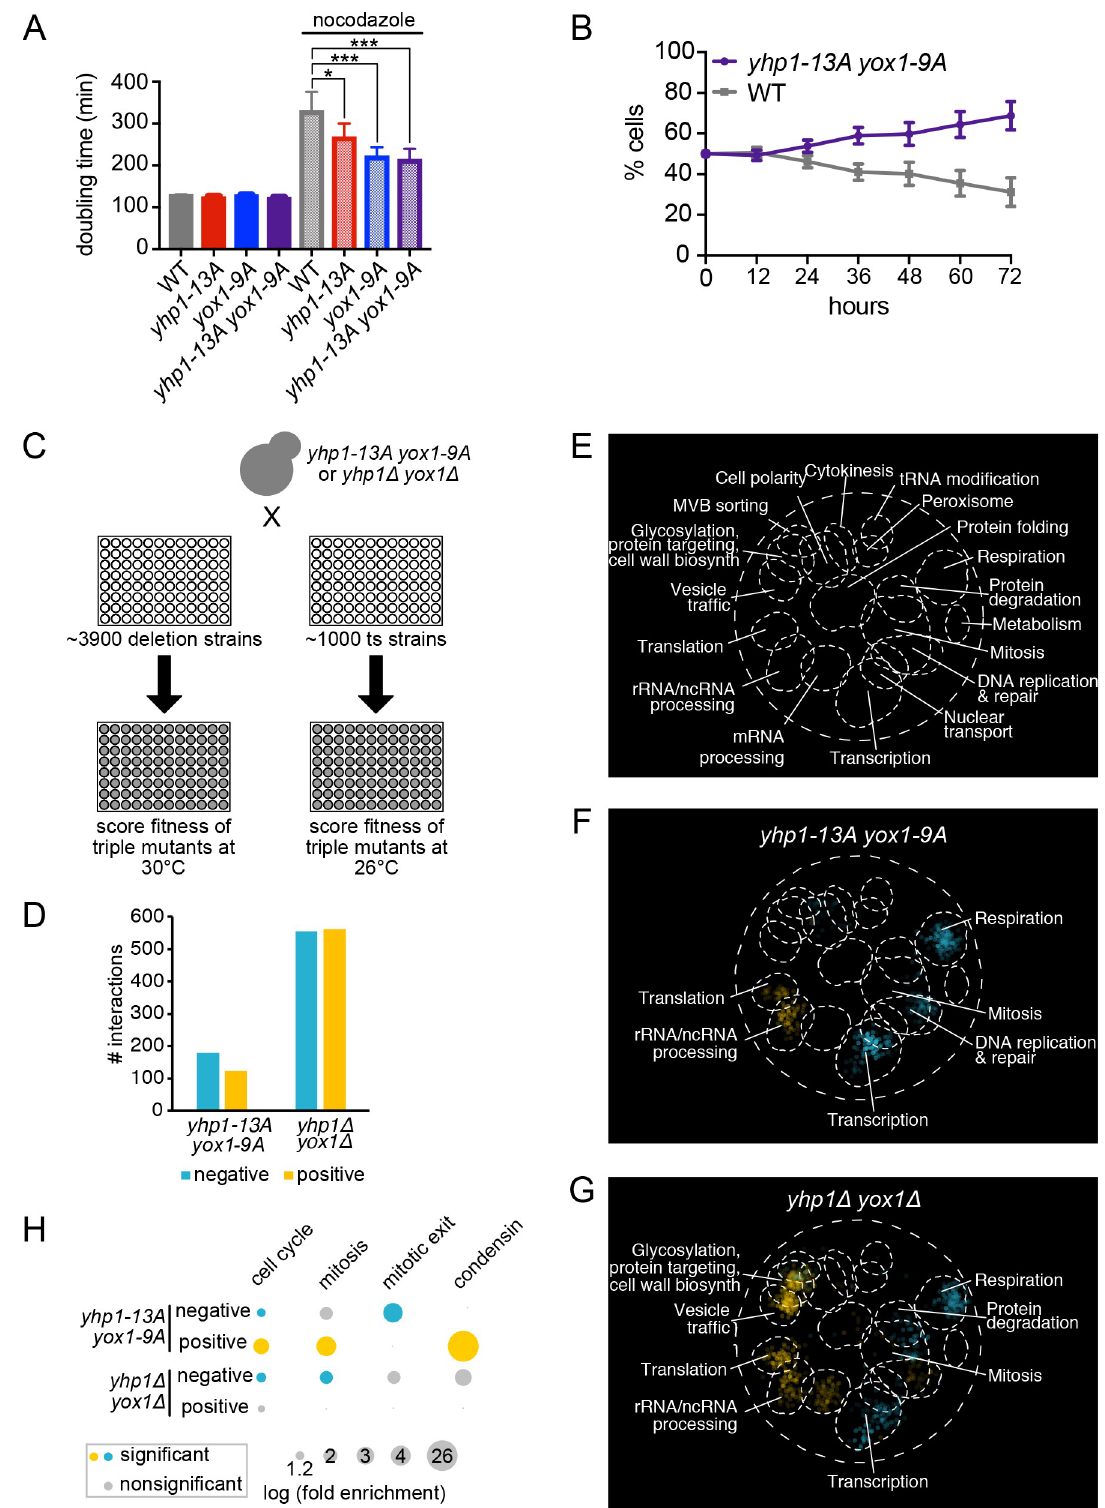
Fig 1. Identification of genetic interactions with yox1 yhp1 mutant strains. (A) Doubling times of wild type (WT) or mutant strains with the indicated genotypes grown in rich media without (solid bars) or with (speckled bars) 5 μ g/ml nocodazole at 30˚C. Shown is an average of n = 6 experiments, error bars indicate standard deviations. Significance was tested using an unpaired t-test, � p < 0.05,